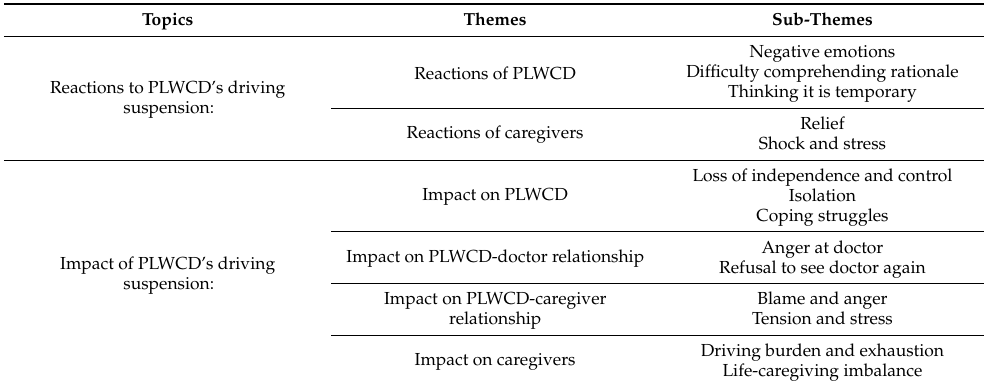
Table 2. Summary of qualitative data analyses regarding driving